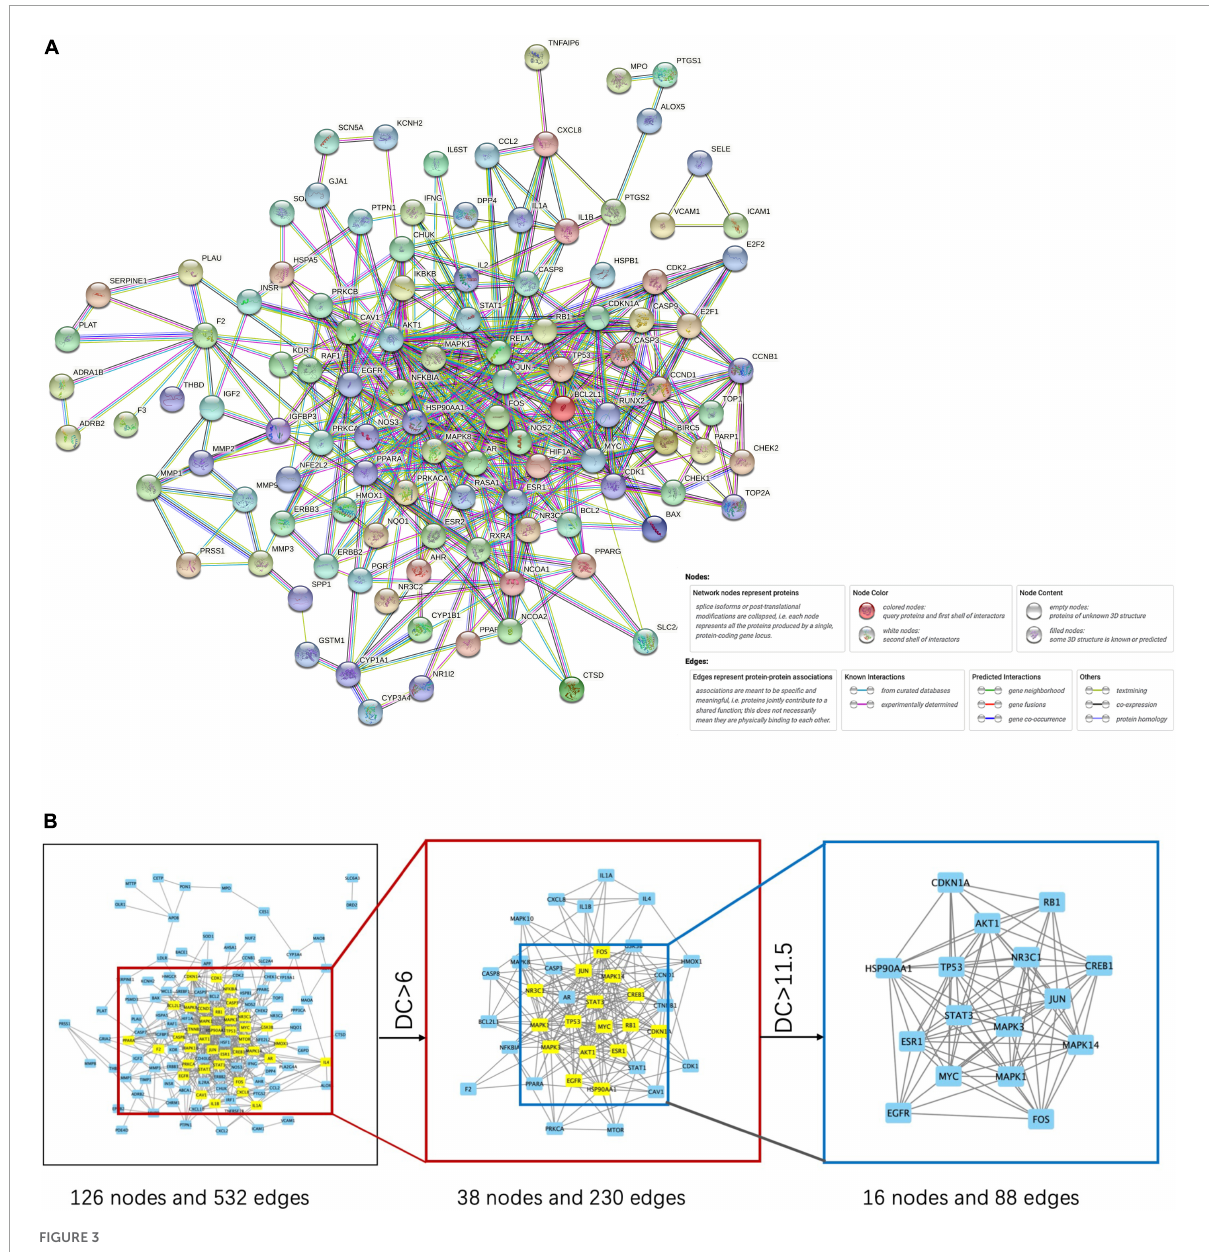
FIGURE3 PPI network (A) and its key target network (B)